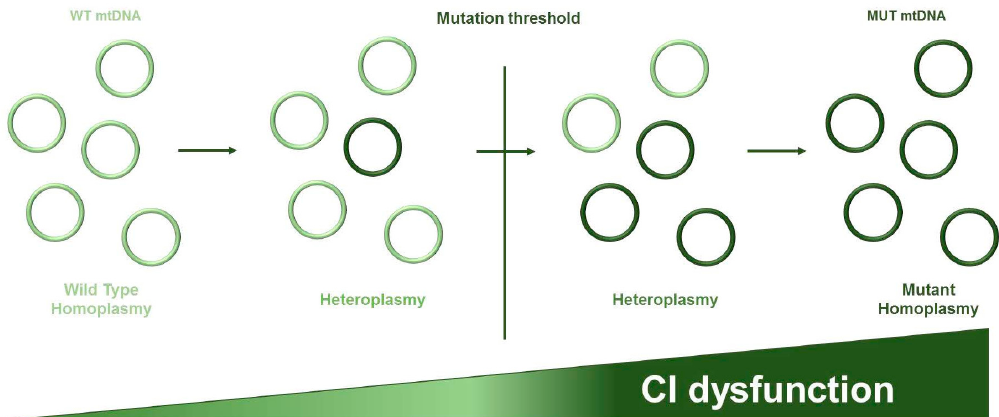
Figure 2. Mitochondrial DNA exists in multiple copies in every cell. The condition of homoplasmy is reached when all mitochondrial DNA (mtDNA) molecules are identical (wild type (WT) or mutant (MUT)), while heteroplasmy is referred to the coexistence of different mitogenomes. Hence, to exert their functional effect mtDNA mutations must be accumulated and surpass a specific mutation threshold that depends on the mutation type and the tissue or cell affected.